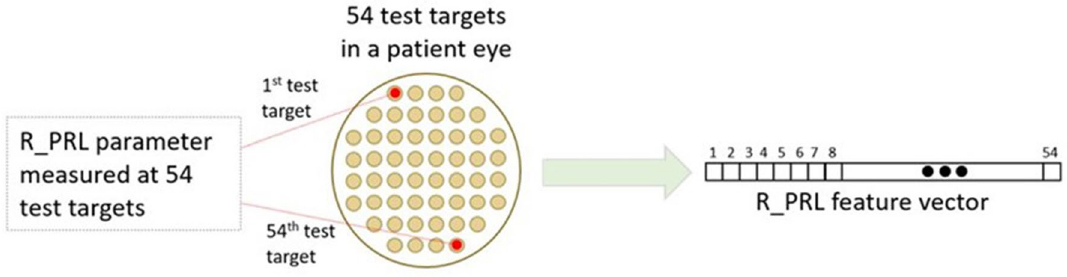
Figure 5. An illustration of a feature vector extraction process from a participant’s chromatic pupilloperimetry test. Here a vector for the Pupil Response Latency of a red stimulus (R_PRL), measured in 54 test targets, was generated. The process was repeated per both eyes of each